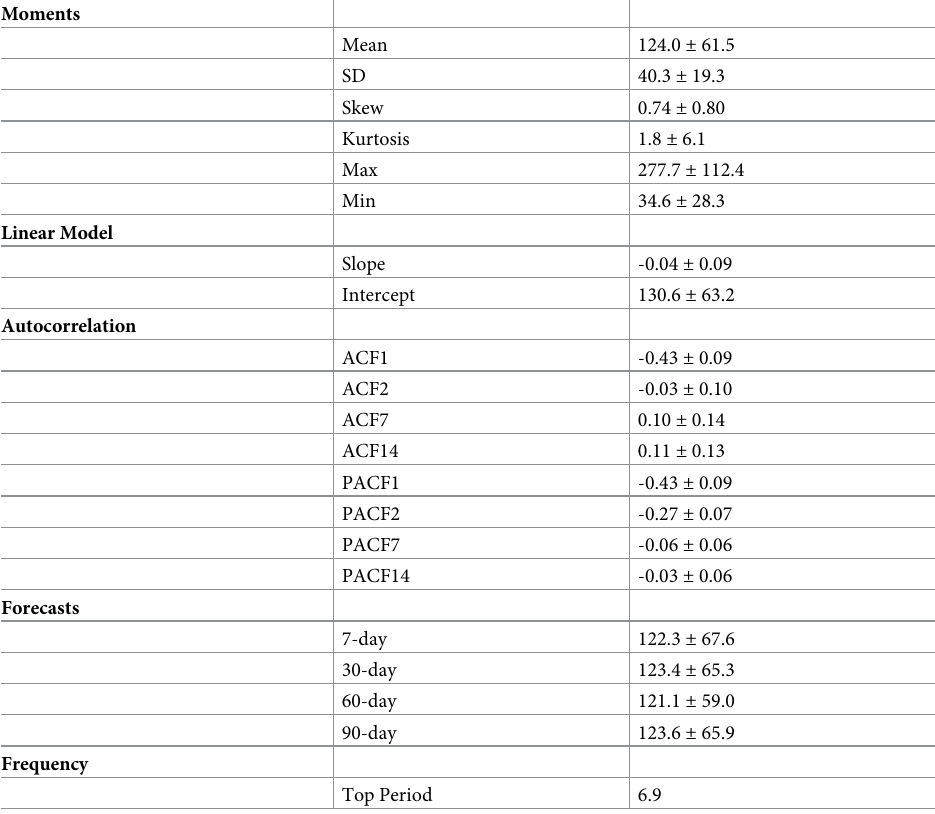
without VT events. Table 2 shows the population average values for each feature extracted from the activity time series for each patient. For the top period obtained using frequency domain approaches, the mode is displayed in days, corresponding to close to a weekly (~7 day) cyclical period for most subjects. Noteworthy is that the average linear trend across Table 2. Physical activity summary information about for each patient (N = 235).